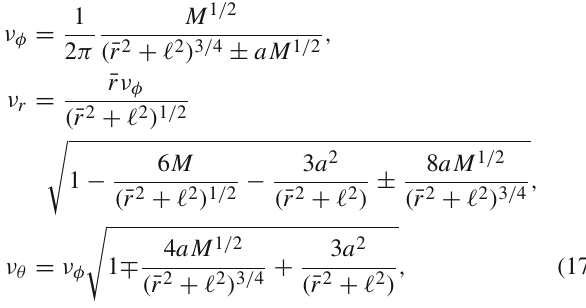
which can be used to constrain the four parameters (cid:5) , ¯ r , M , and a of the rotating SV metric. Here, the top/bottom row of the ± and ∓ signs corresponds to the orbit co- rotating/counter-rotating with the spacetime. To illustrate the dependence of the epicyclic frequencies on (cid:5) , we plot ν φ , ν (cid:5) for various values of a in ν per and nod as a function of Fig. 2, where M = 1 and ¯ r = 6. The prograde and retro- grade cases are represented by solid and dashed lines, respec- tively. The left panel shows that, for a fixed a , the azimuthal epicyclic frequency ν φ decreases with (cid:5) increasing in both prograde and retrograde cases, whereas ν φ of the prograde orbit is smaller than that of the retrograde orbit. The peri- astron precession frequency ν per is displayed in the middle panel, and also decreases as (cid:5) increases for both prograde and retrograde orbits. Like ν φ , the retrograde orbits have larger ¯ r = 6 do ν per . Note that retrograde circular orbits of radius not exist when (cid:5) is small enough. However, as shown in the right panel, the nodal precession frequency ν nod of the pro- grade/retrograde orbits decreases/increases as (cid:5) increases for a given a . More interestingly, when a > 0, ν nod of the